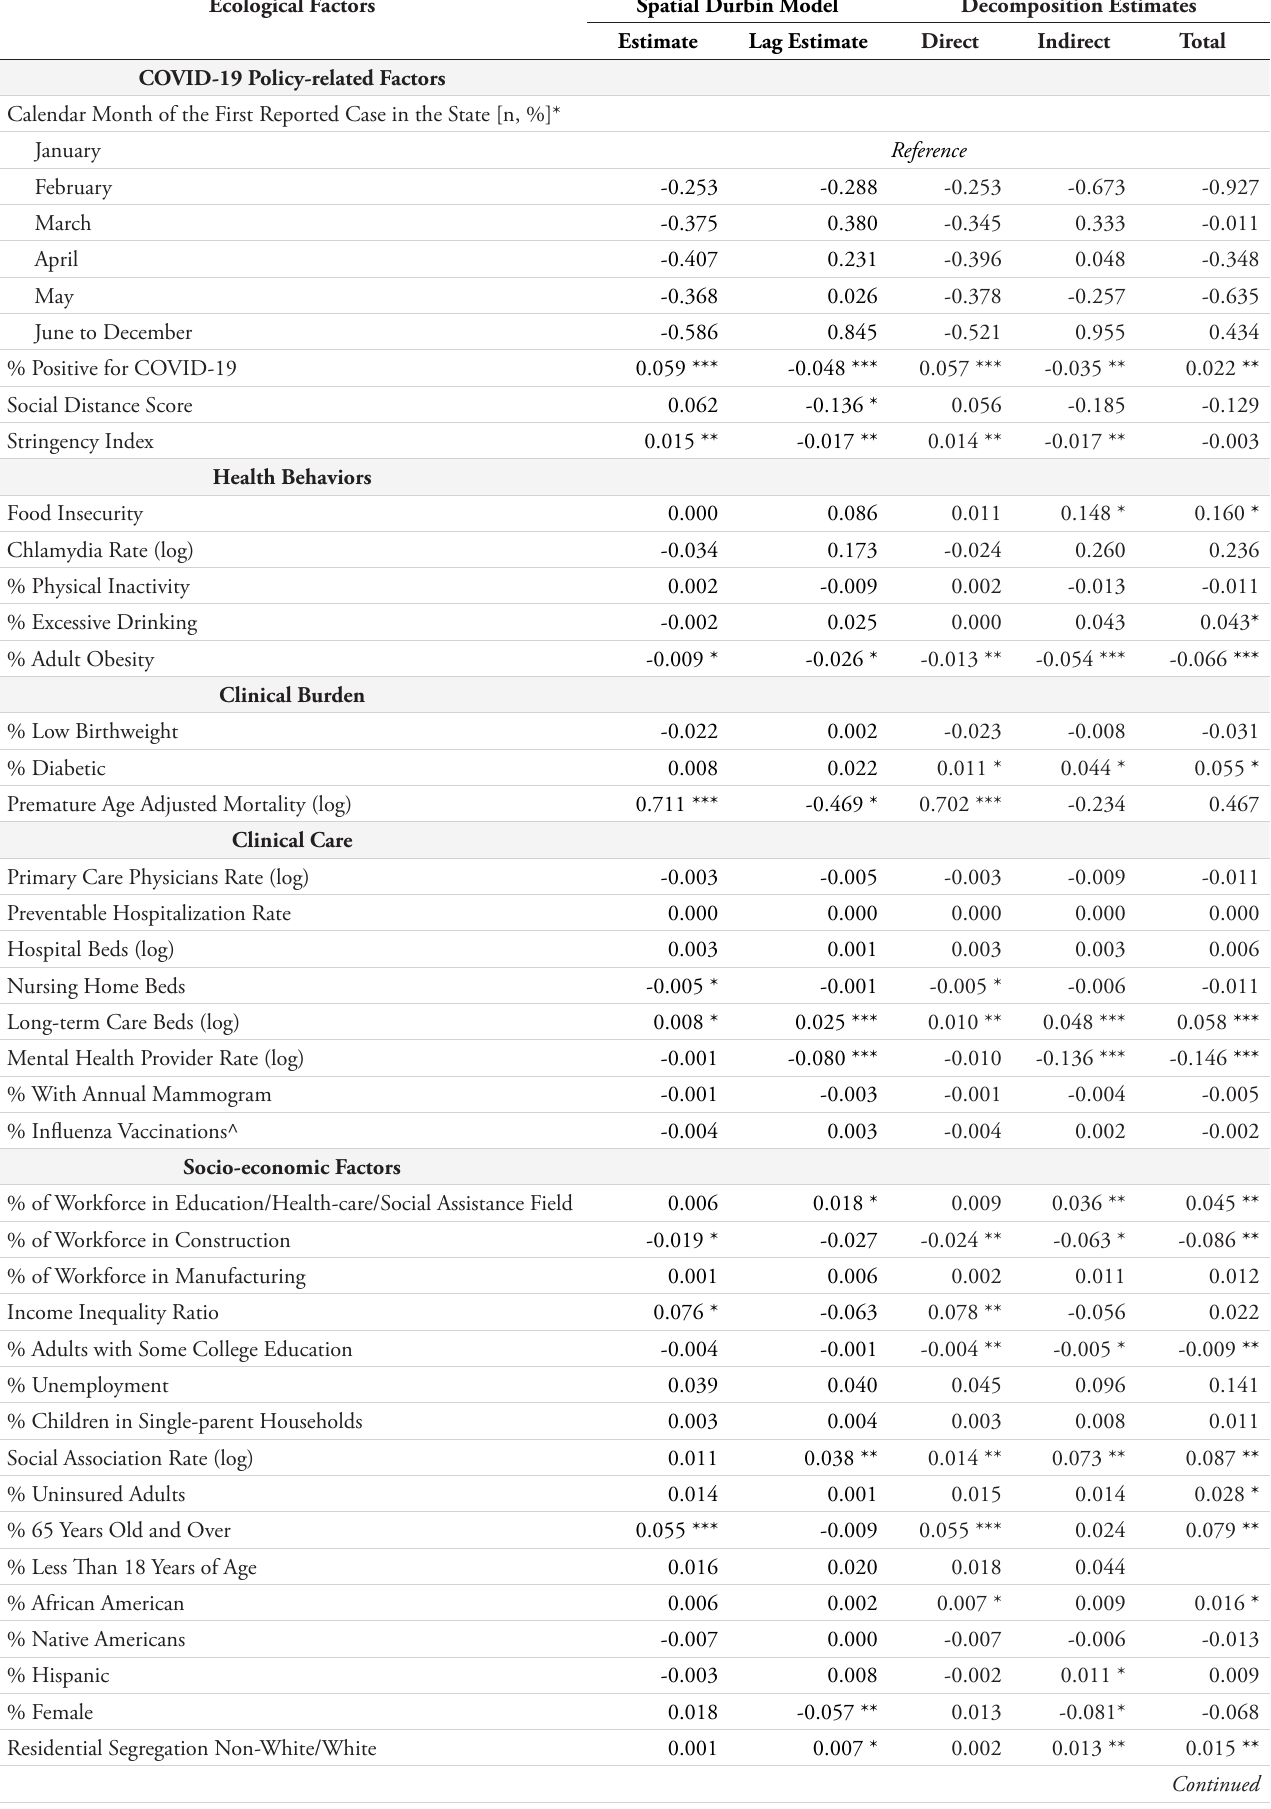
Table 3: Spatial Durbin Model for the Case Fatality Rates as of February 27, 2021 Using NYT 1 , AHRF 24 , and CHRF 26